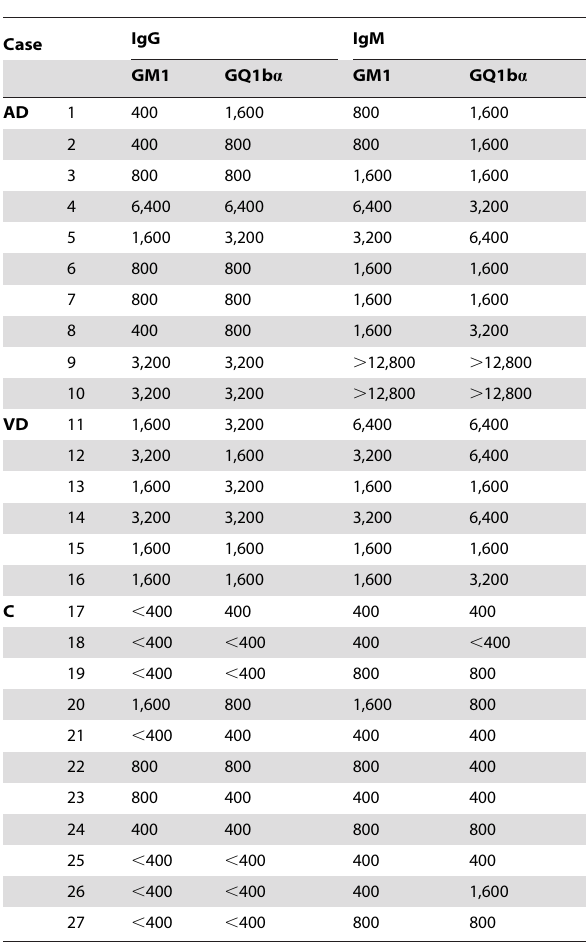
Table 3. Titers of anti-glycosphingolipid, GM1 and GQ1b a antibodies in sera of demented patients, and age-matched